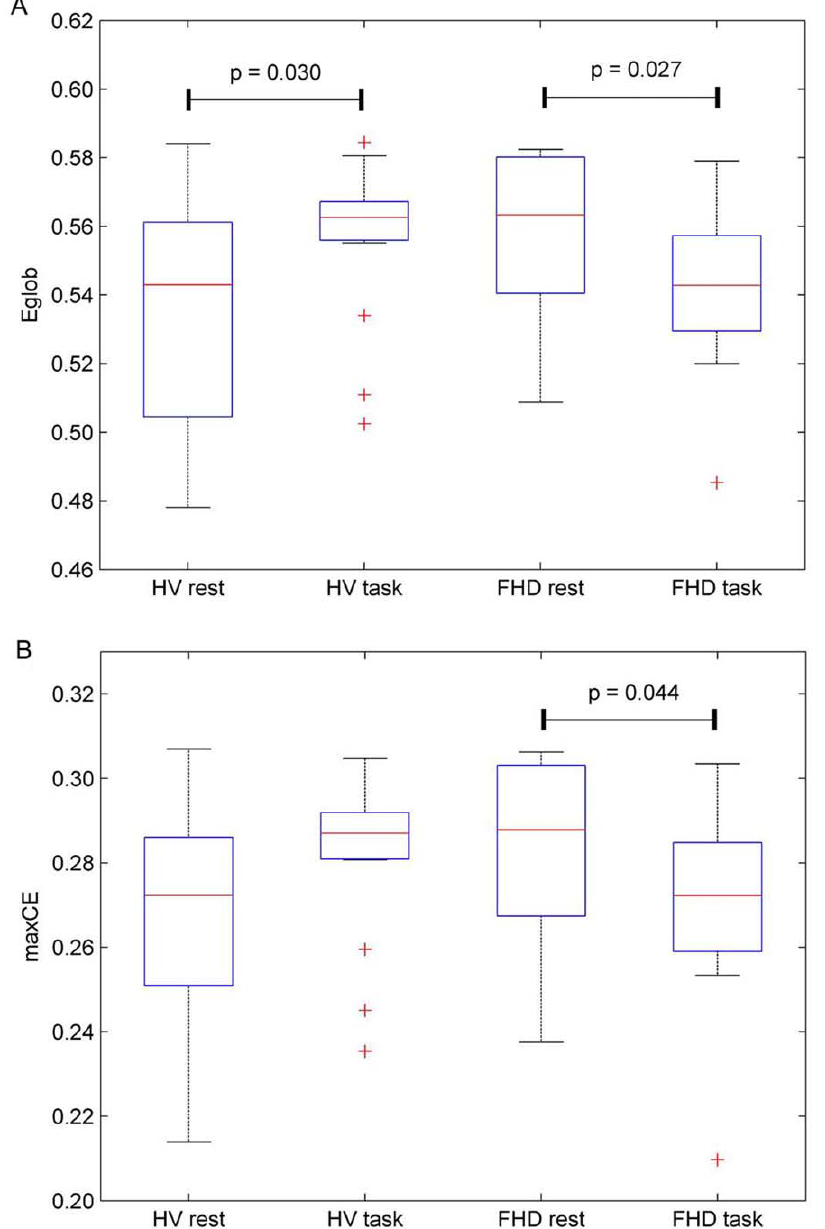
Figure 3. Box-plots of Eglob at a cost 0.28. Box-plots showing median, interquartile, and range for Eglob (a) at a cost 0.28, which shows the most significant interaction effects of group and condition on Eglob , and for max CE (b). Eglob in FHD is diminished during a task, while healthy volunteers show enhanced Eglob . Note that CE would be the same as Fig. 4a, because it denotes the Eglob at a given fixed cost 0.28. FHD patients show a diminished max CE during a task. Each horizontal line and the associated number represent the p -value of a post-hoc t -test.